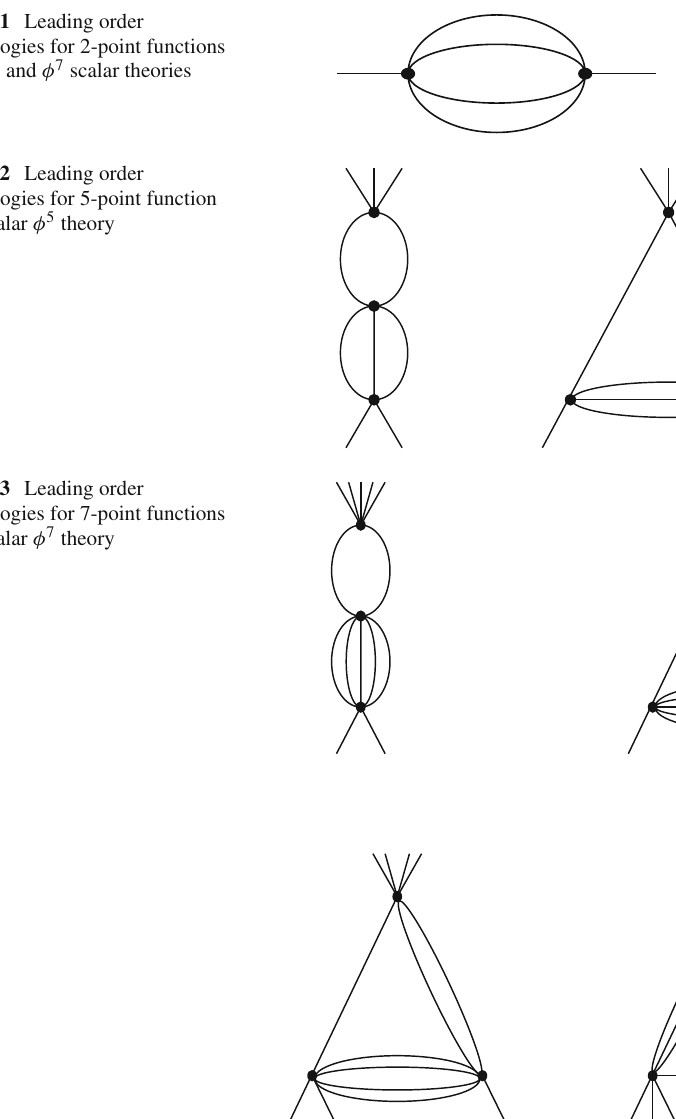
topologies for 5-point function in scalar φ 5